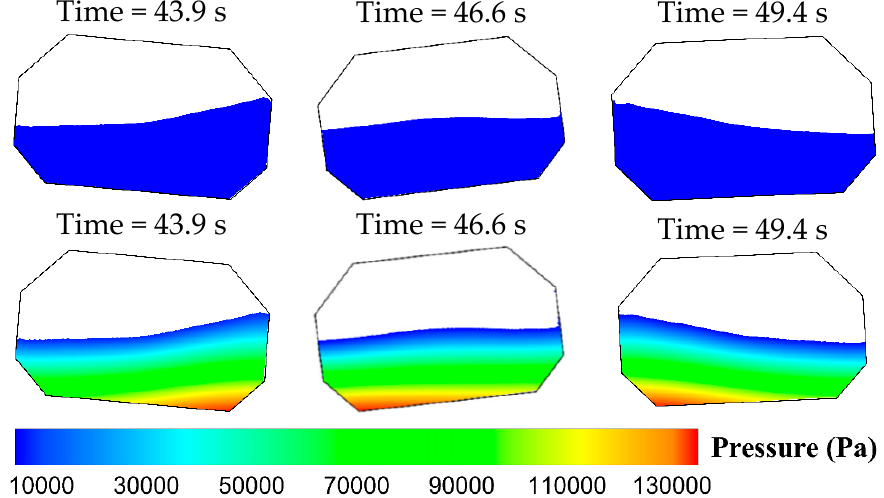
Figure 8. Snapshots of free surfaces ( first line ) and corresponding pressures ( second line ) in the case T = 10.0 s at various moments.